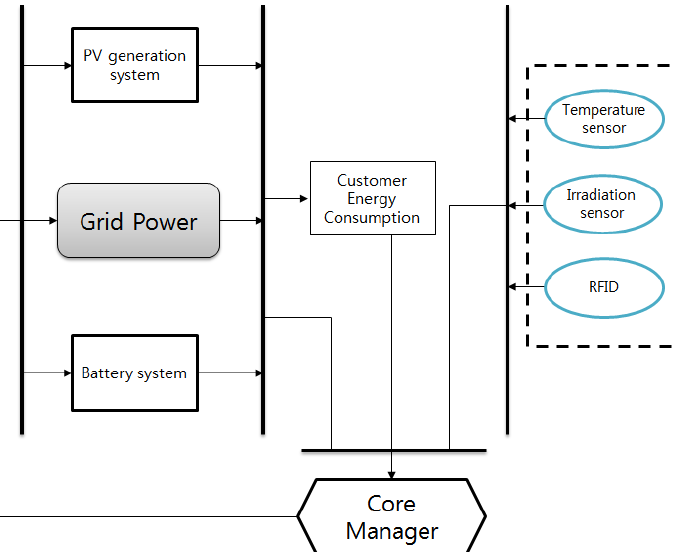
Figure 1. Configuration of the proposed premise energy management